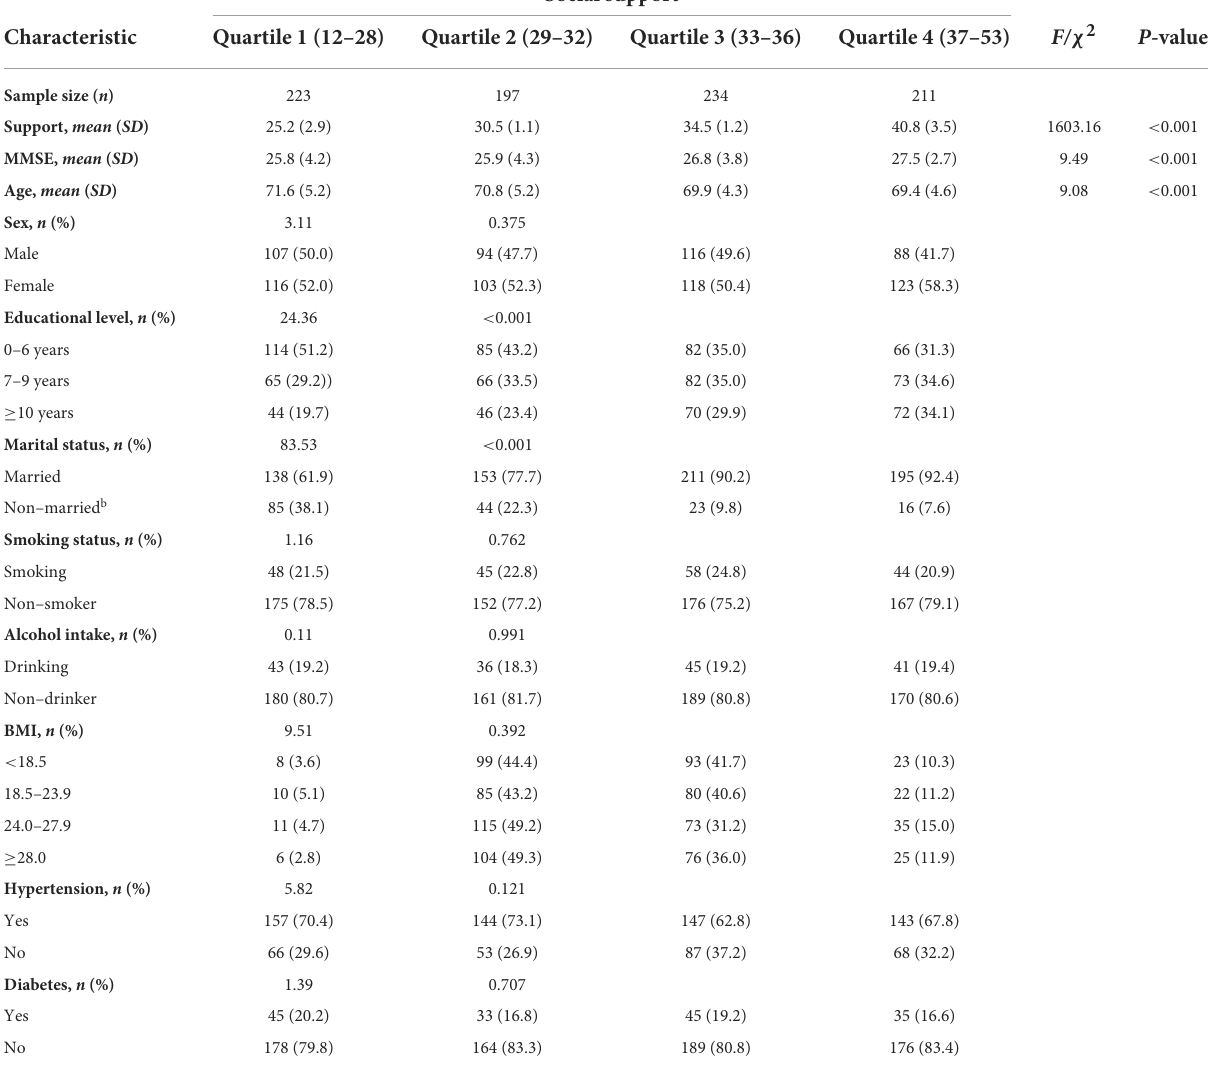
TABLE 2 Baseline characteristics of study population according to quartiles of social support scores a